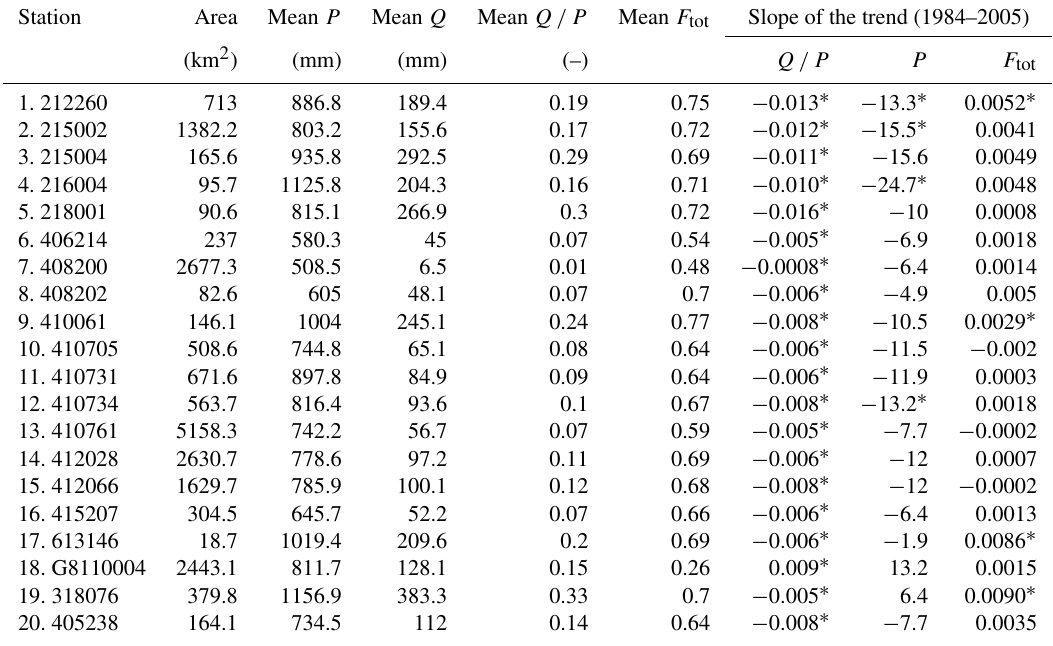
Table 1. Mean annual precipitation ( P ), discharge ( Q ), runoff ratio ( Q/P ) and fractional vegetation cover ( F tot ) of catchments with non- stationary hydrologic response during the 1984–2005 period. Slopes of the trend lines are obtained from a linear regression model fitted to each time